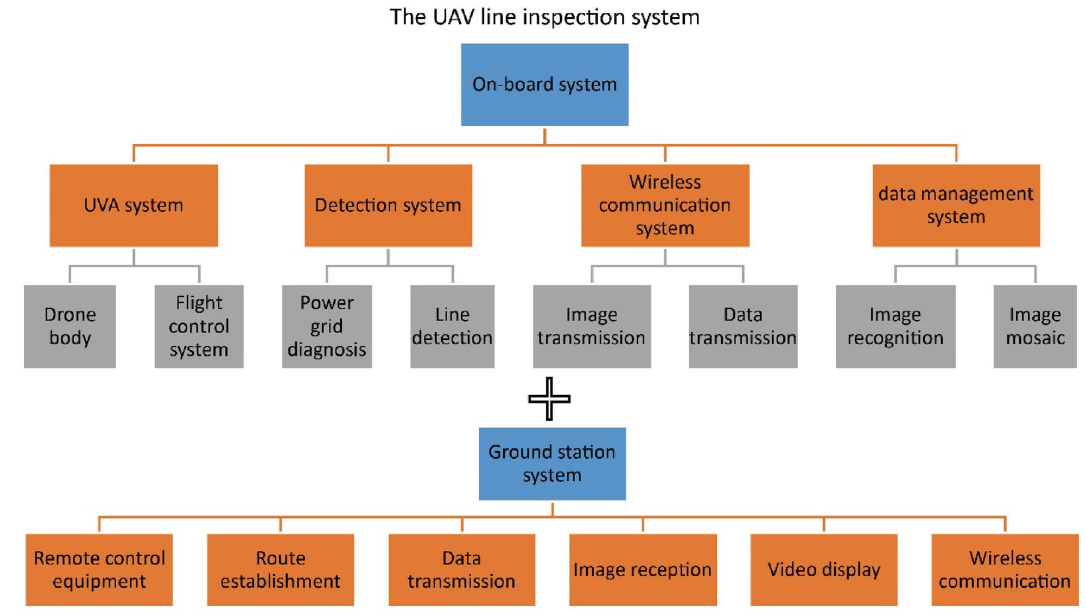
Fig. 2 Structure and system of UAV Inspection